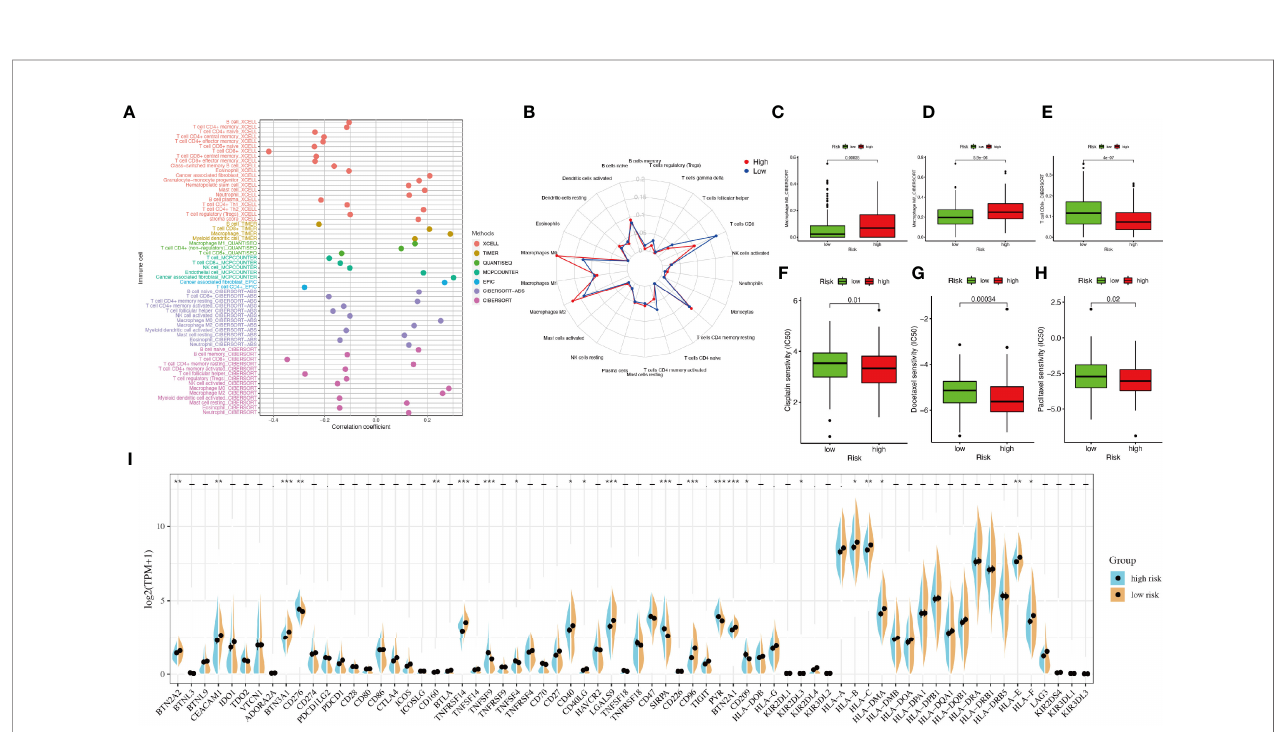
FIGURE 5 | Tumor-in fi ltrating immune cells and chemotherapeutics. (A) The relationship between immune cells and riskScore. Each color represented a distinct algorithm. (B) The proportions of immune cells in the high- and low-risk groups. (C – E) The proportions of macrophages M0, macrophages M2, and CD8+ T cell in the high- and low-risk groups. (F – H) The half-maximal inhibitory concentration (IC50) of 3 common chemotherapeutic agents (cisplatin, docetaxel, and paclitaxel). (I) The expression of 68 immune checkpoint genes in the high- and low-risk groups. *P < 0.05, **P < 0.01, ***P <